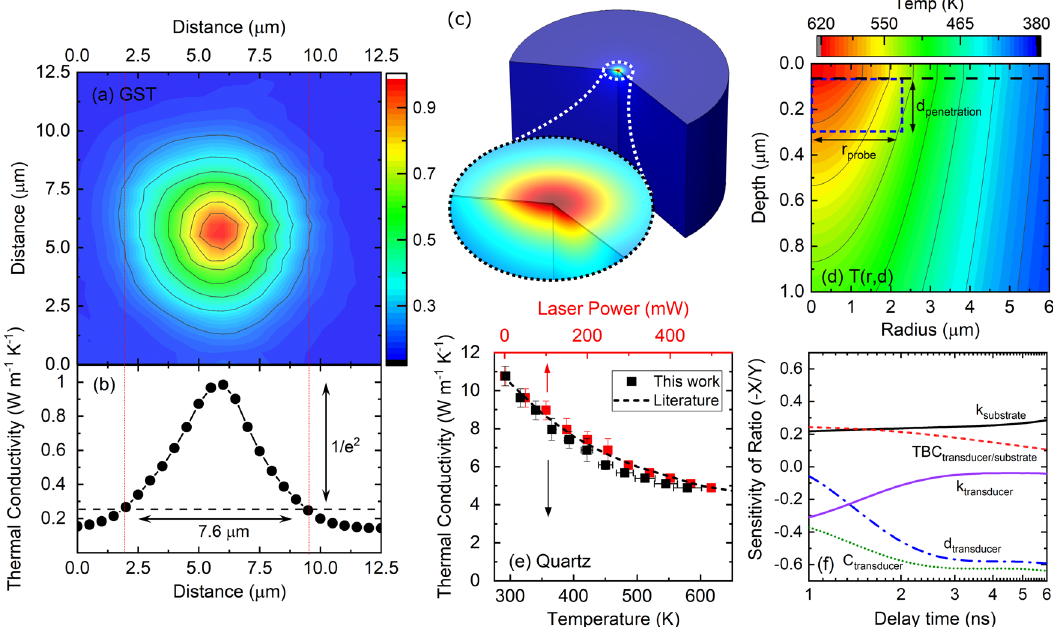
Fig. 2 Thermal conductivity and temperature pro fi le as a result of a localized heating source from a laser beam. a The thermal conductivity map for a blanket coated sample with 60 nm ruthenium on a 40 nm thick phase-change material (Ge 2 Sb 2 Te 4 ) on a silicon substrate exposed to a heater laser with 740 mW. b Thermal conductivity pro fi le of phase-change material as a function of distance. c Simulation domain for Al/Quartz and its corresponding temperature rise, ( d ) 2D temperature pro fi le in the quartz and the region probed by TDTR beam, ( e ) thermal conductivity of quartz as a function of temperature and laser power. The x -axis and y -axis uncertainty are calculated based on standard deviations in temperature of probed volume and thermal conductivity measurement of three different spots, respectively. f Sensitivity analysis for the 80 nm SRO-transducer/60 nm PZO/15 nm SRO/DSO- substrate con fi guration for parameters such as thermal conductivity, k , volumetric heat capacity, C , thermal boundary conductance, TBC, and thickness,